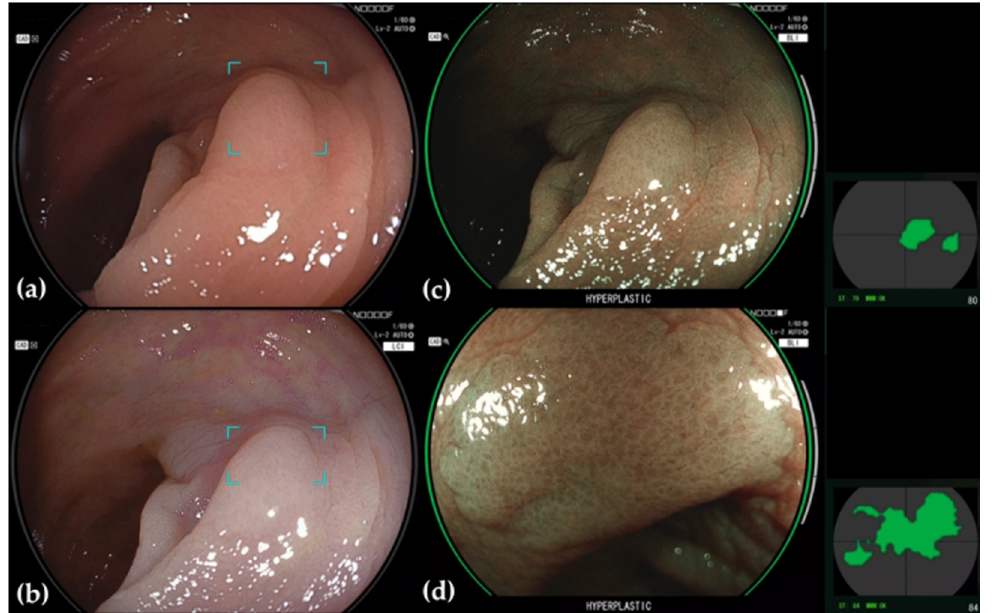
Figure 3. Hyperplasic polyp detected and diagnosed by CADEYE. ( a ) The margins of the area around a suspected polyp detected under WLE are delineated. ( b ) This area is similarly delineated under LCI. ( c ) If the lesion is determined to be hyperplastic under BLI, the endoscopic image is ringed in green, and the word “HYPERPLASTIC” is displayed beneath. The location where the de- termination is being conducted is also shown to the right of the endoscopy image. ( d ) Magnified BLI image.